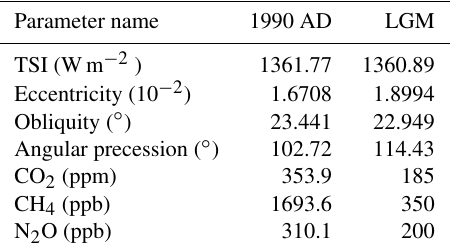
Table 1. External forcing used in Hofer et al. (2012a, b) for 1990 AD and LGM